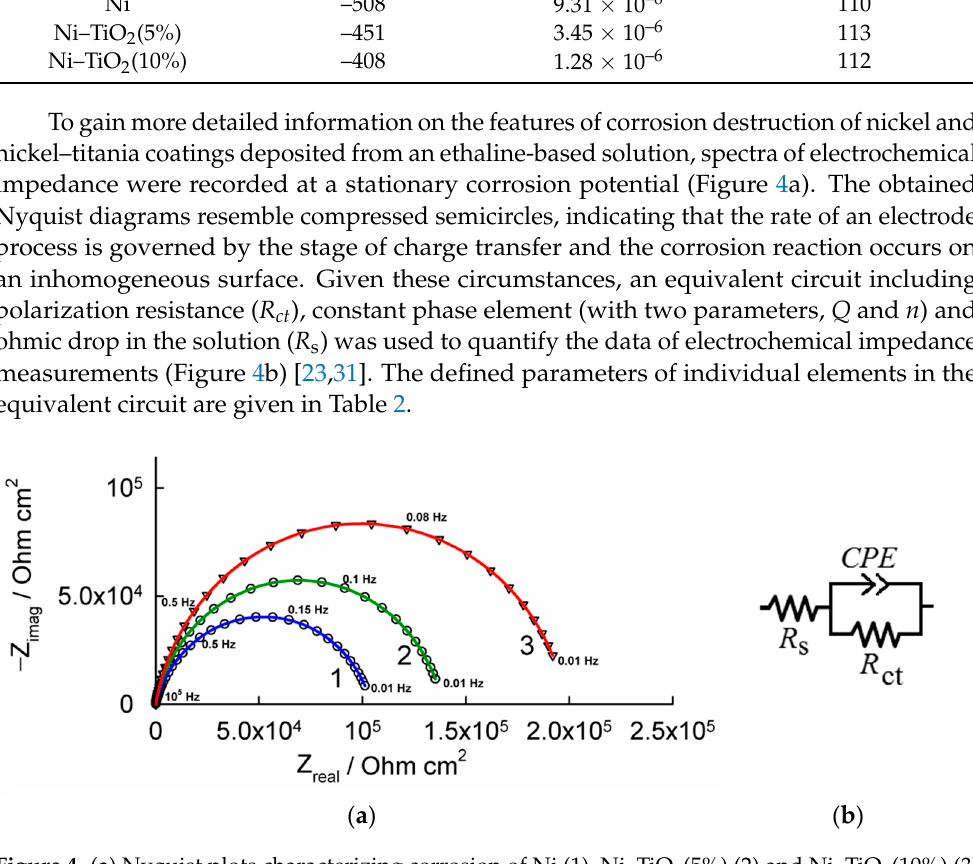
Figure 4. ( a ) Nyquist plots characterizing corrosion of Ni (1), Ni–TiO 2 (5%) (2) and Ni–TiO 2 (10%) (3) coatings in a 3% NaCl aqueous solution at 298 K; ( b ) adopted equivalent circuit.